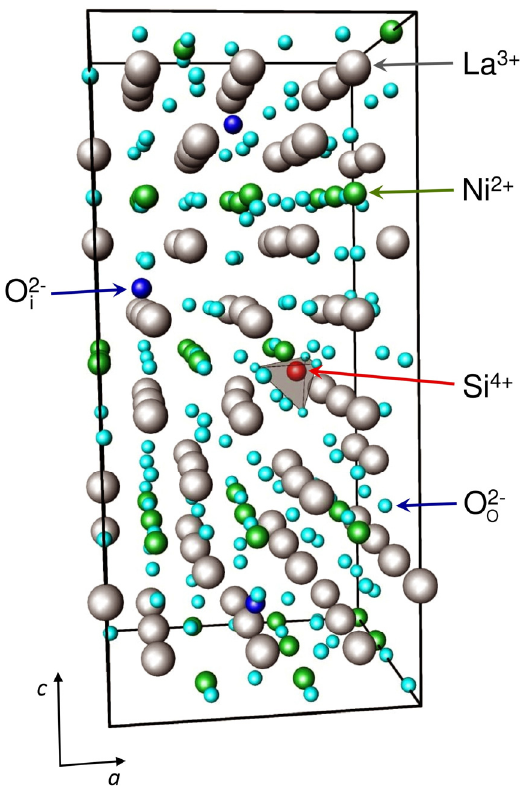
Figure 5. Simulated La 2 Ni 0.972 Si 0.028 O 4.028 supercell with configuration (iii) after geometry optimization.